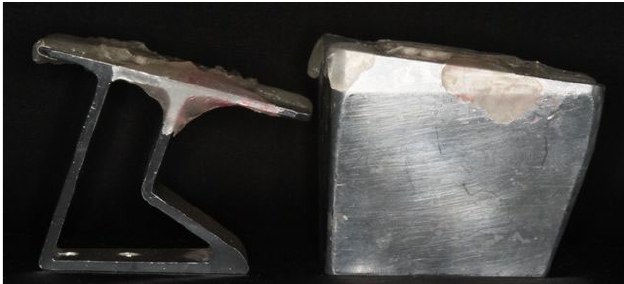
Fig. 2. Lateral view of the splints with a flat inferior surface adapted with acrylic resin on the superior surface of the seven and thirteen degrees planes.